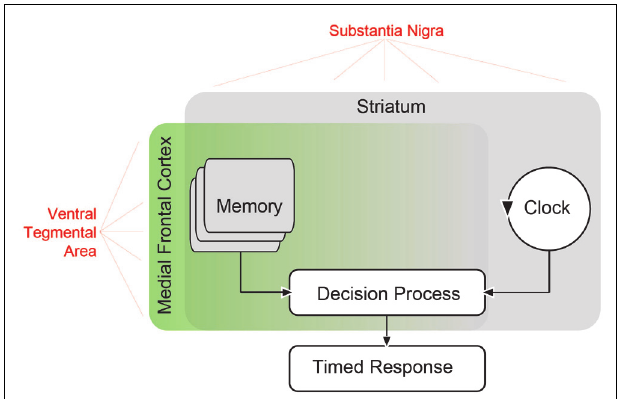
FIGURE 1 | Scalar timing theory of interval timing based on that proposed by Church (1984) . In this model, an external signal such as a sensory cue starts an internal clock, which compares the passage of time with a criterion stored in working memory.When the criterion approaches the actual clock time, a timed response is initiated. Extensive evidence has suggested that the striatum is involved in all aspects of interval timing (Merchant etal., 2013). Both dorsal and ventral striatum receive dopaminergic input from the substantia nigra via the nigrostriatal pathway, and this pathway can influence timing (Meck, 2006). However, areas in the medial frontal cortex may also be involved (Coull etal., 2011), and likely influence memory as well as decision processes (Mehanna and Jankovic, 2013).These areas receive dopaminergic input (in red) from mesocortical dopamine projections originating from the ventral tegmental area.These mesocortical dopamine projections may contribute to perceptual timing deficits in PD